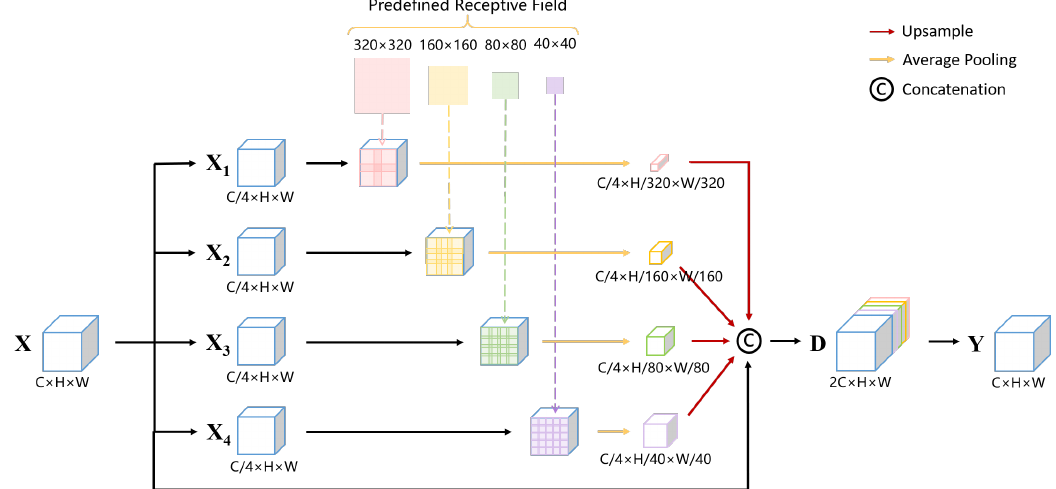
Figure 4. Detailed design of the adaptive spatial pooling